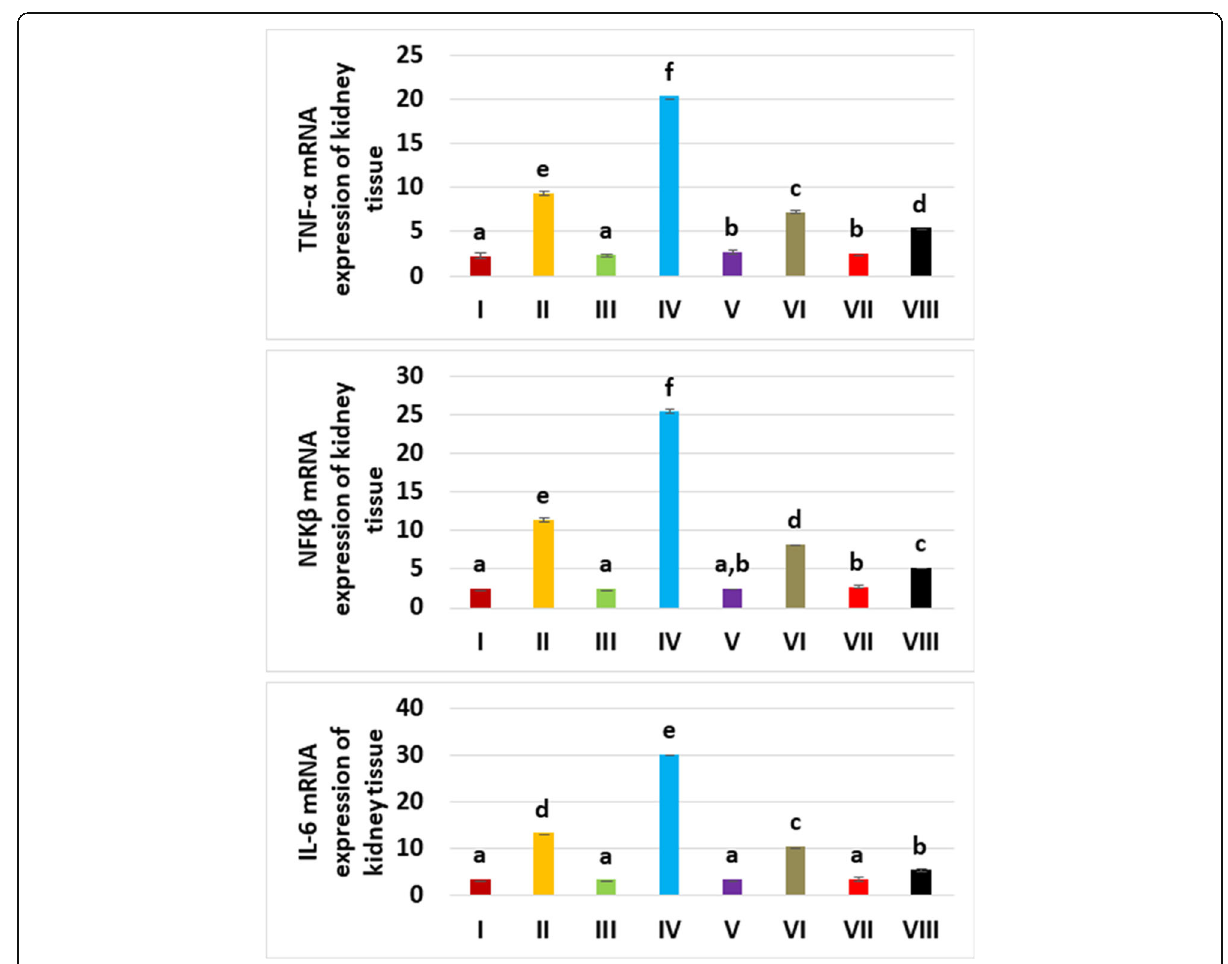
Fig. 4 Tissue tumour necrosis factor- α (TNF- α ), nuclear factor kappa β (NFK- β ), and interleukin 6 (IL-6) mRNA expression of the experimental groups. TNF- α , NFK- β , and IL-6 mRNA expressions are promoted by glycerol and contrast media administration. However, levosimendan lowered the